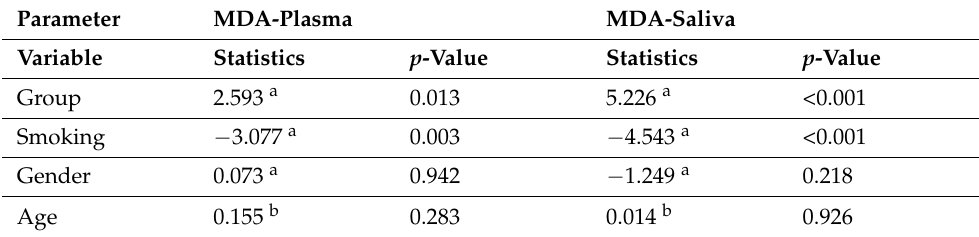
Table 6. The influence of sex, age and smoking status on the salivary and plasma MDA levels.